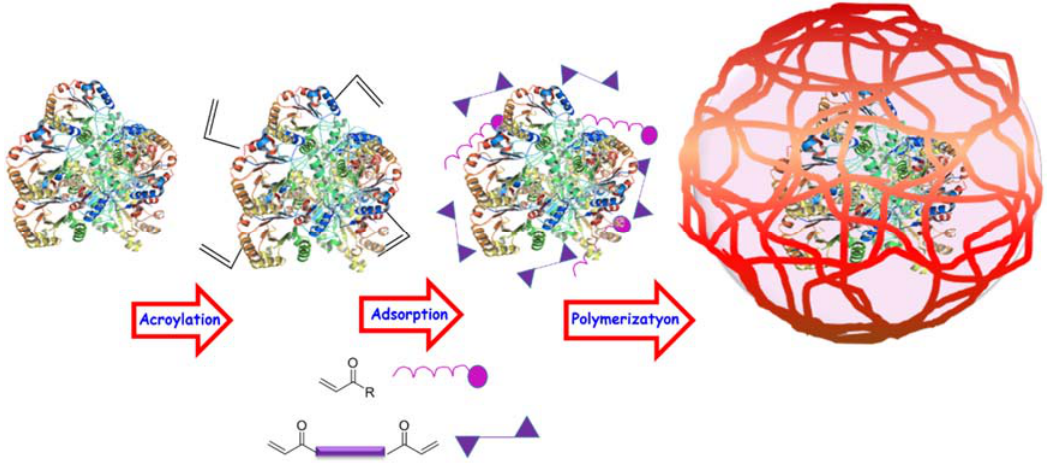
Figure 3. Scheme of the encapsulation process.